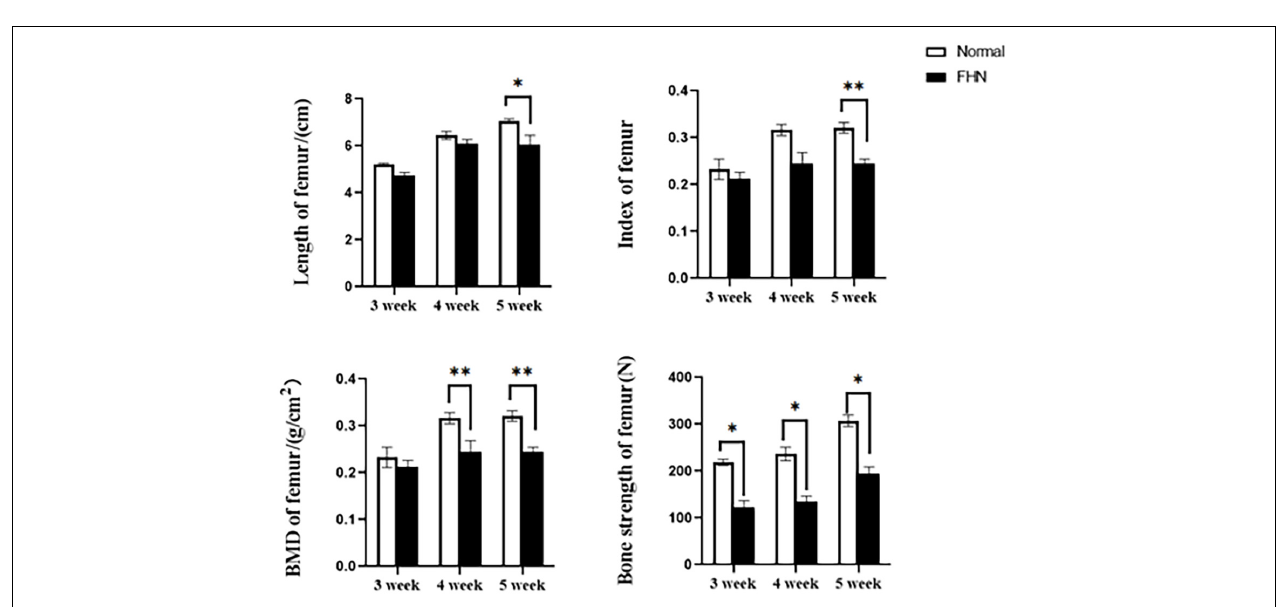
FIGURE 5 | Femur parameters in broilers. ∗ indicates a significant difference ( P < 0.05). ∗∗ indicates an extremely significant difference ( P <